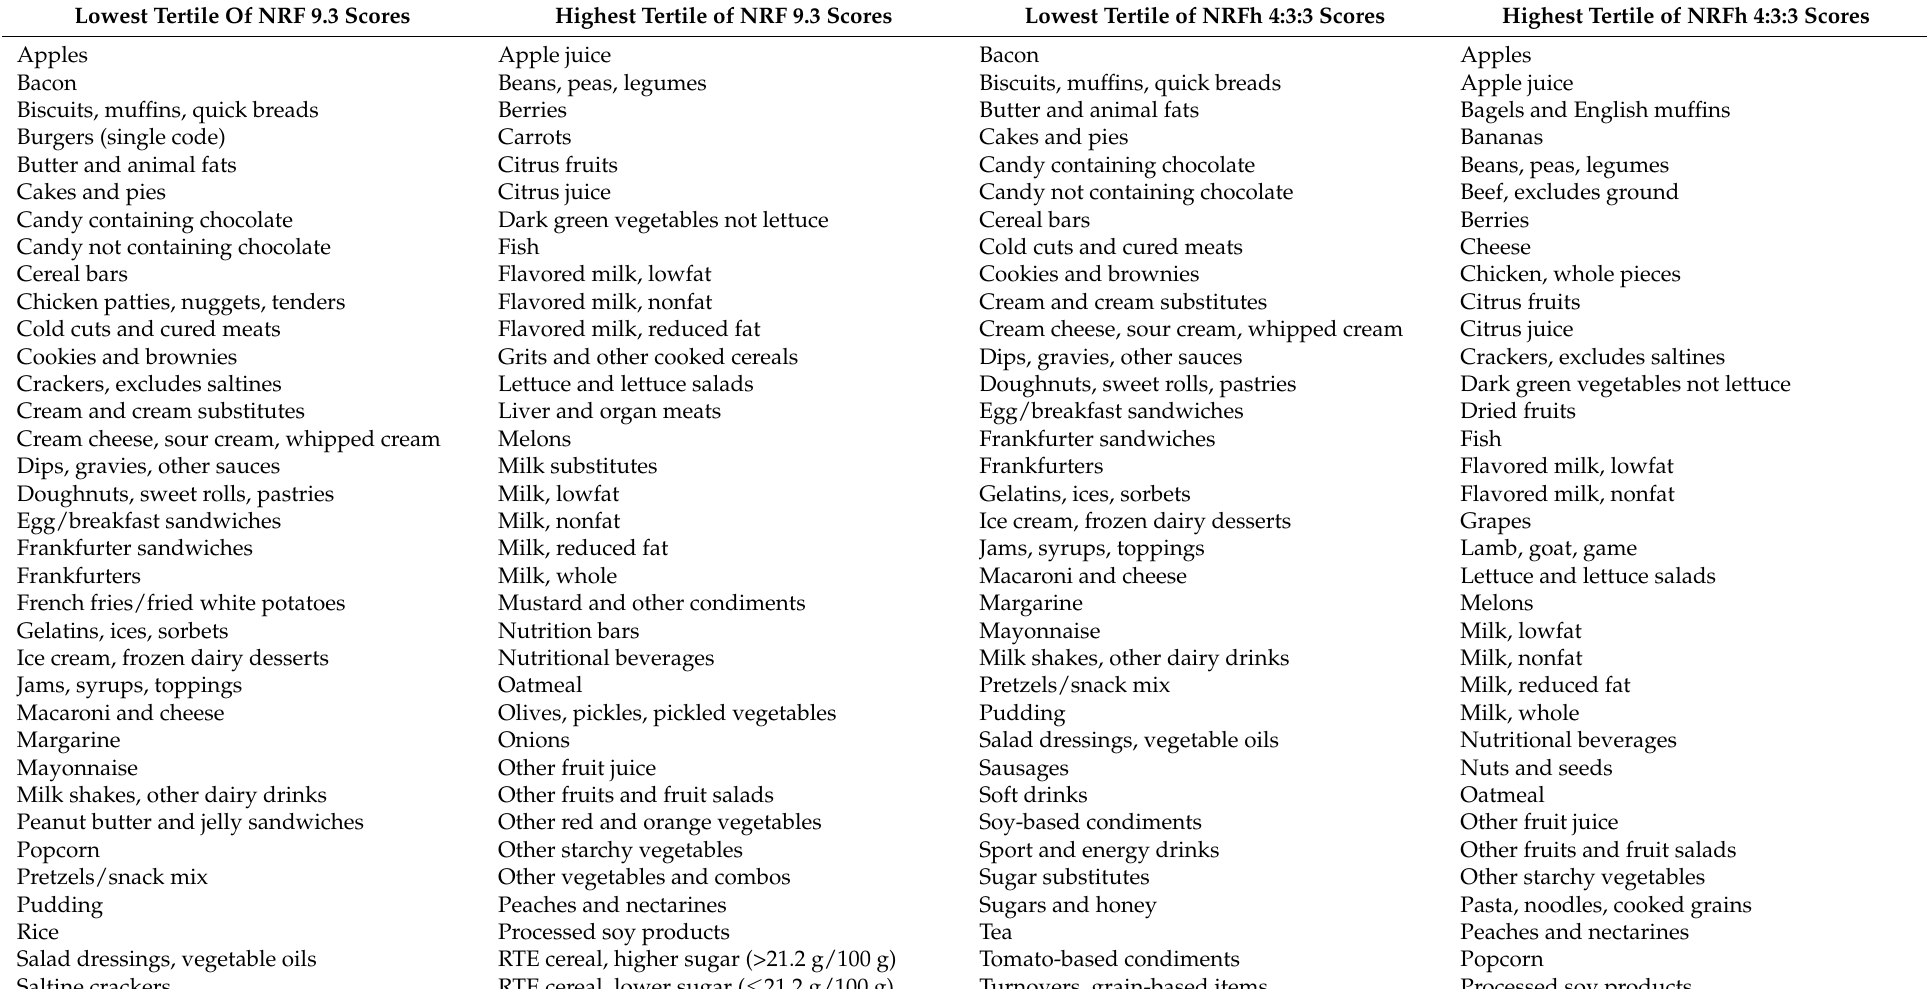
Table 4. Lowest and highest ranking food categories (tertiles of NRF 9.3 and NRFh 4:3:3) by What We Eat in America 4-digit